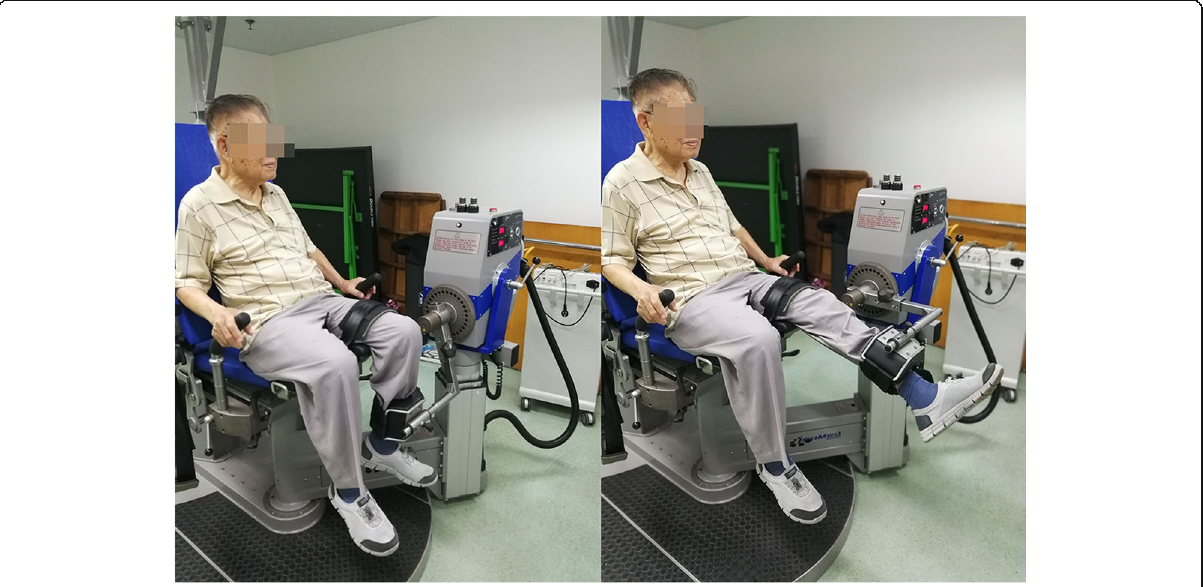
Fig. 1 Isokinetic torque measurement with the IsoMed 2000 dynamometer